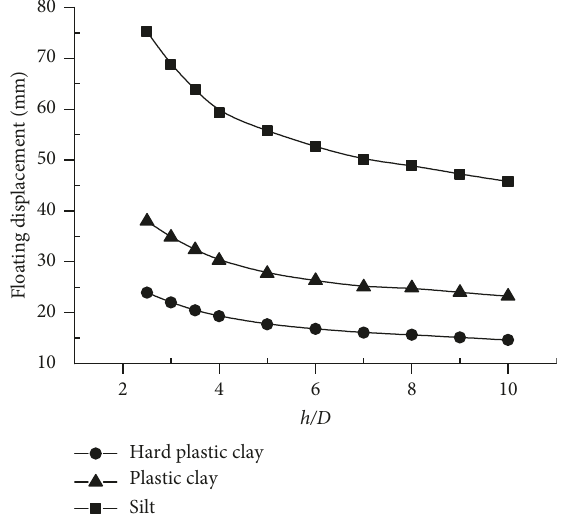
Figure 11: Variation of segment displacement at different geo- logical conditions.